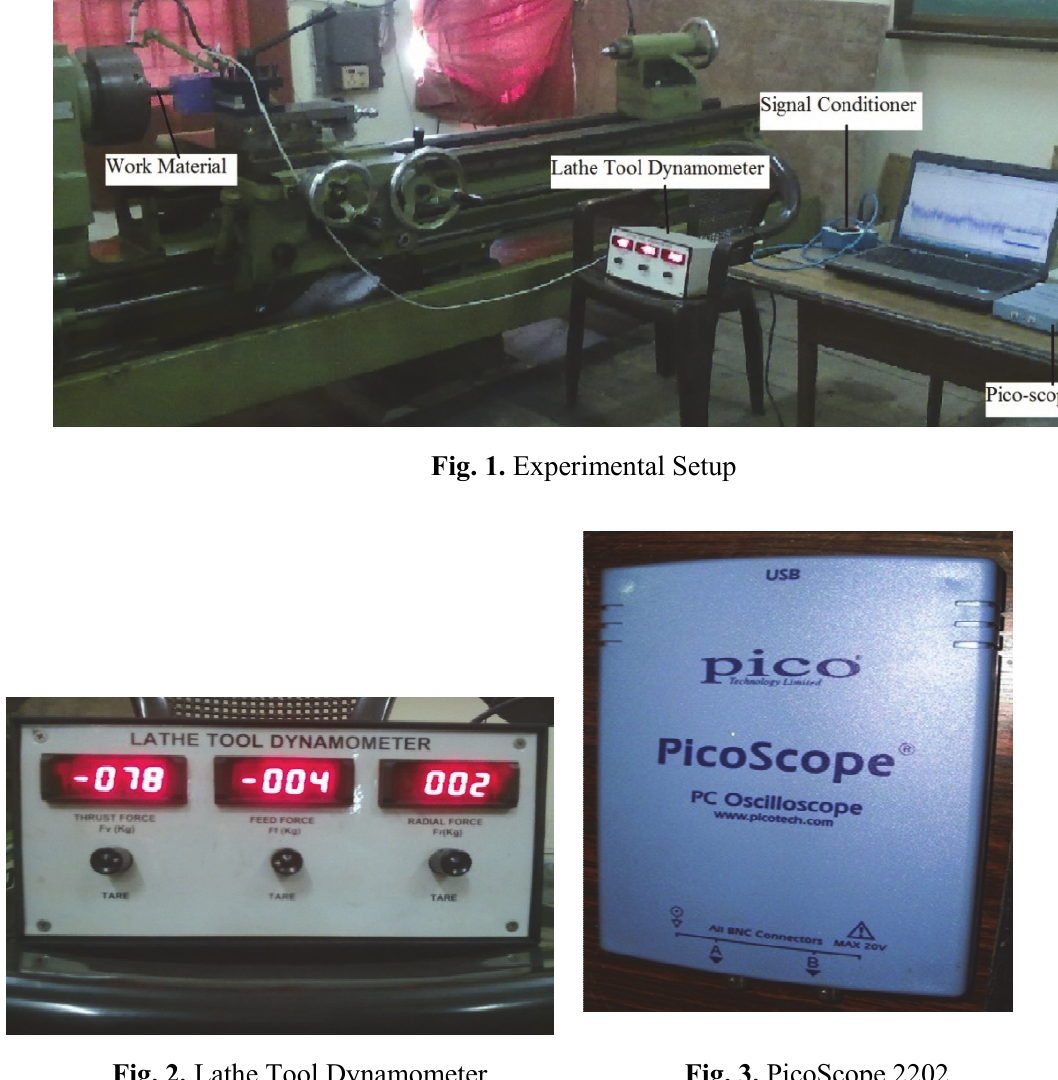
Fig. 2. Lathe Tool Dynamometer Fig. 3. PicoScope